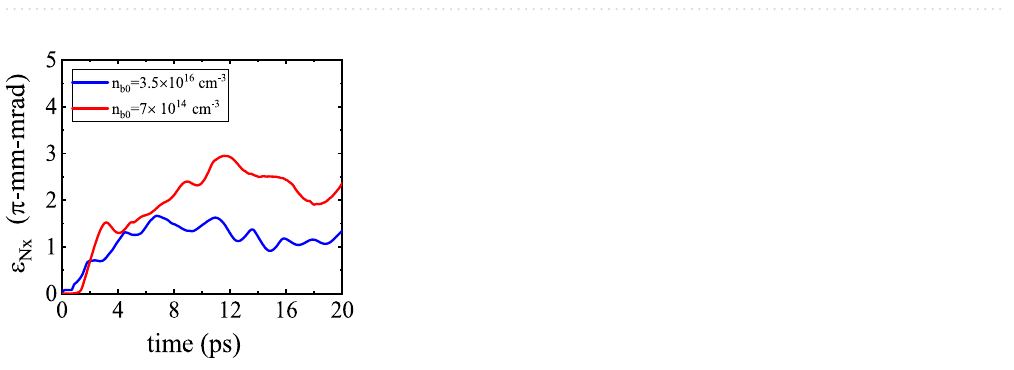
Figure 11. Variation of the bunch emittance ǫ N,x as a function of the propagation time for two transverse 4 µ m and σ x 6.36 µ m . bunch sizes, σ x = =